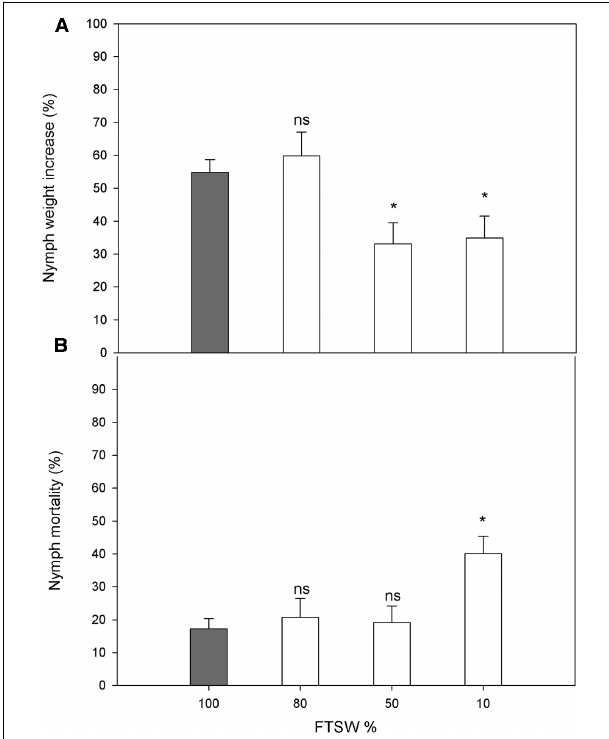
FIGURE 6 | Performance of N. viridula nymphs in well-watered and water-stressed plants. Weight increase (A) and mortality (B) of N. viridula nymphs feeding on V. faba plants under developing water stress. Measurements were made at 100% ( n = 11), 80% ( n = 10), 50% ( n = 13), and 10% ( n = 11) of FTSW. Data are means ± SE. White bars are compared with gray bar (well-watered), ∗ P < 0.05; ns, no significant